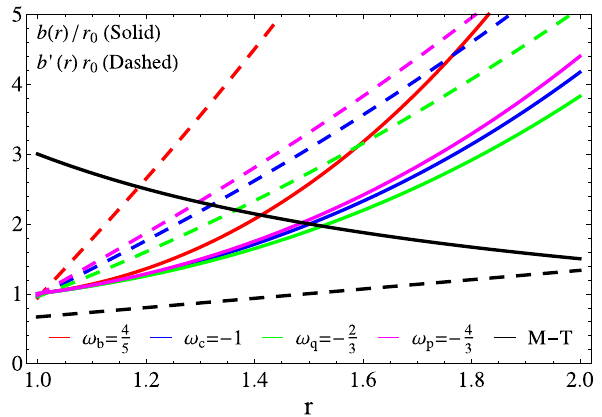
Fig. 1 The trend of the dimensionless shape function b ( r )/ r 0 and the dimensionless flare-out condition b (cid:7) ( r ) r 0 evaluated at the wormhole throat against the radial coordinate r (km), for the model #1. The black curves represent the pure GR counterpart of the model ı.e., the Morris– Thorne (M–T) wormhole space-time. These curves were obtained by using the numerical values provided in Table 3